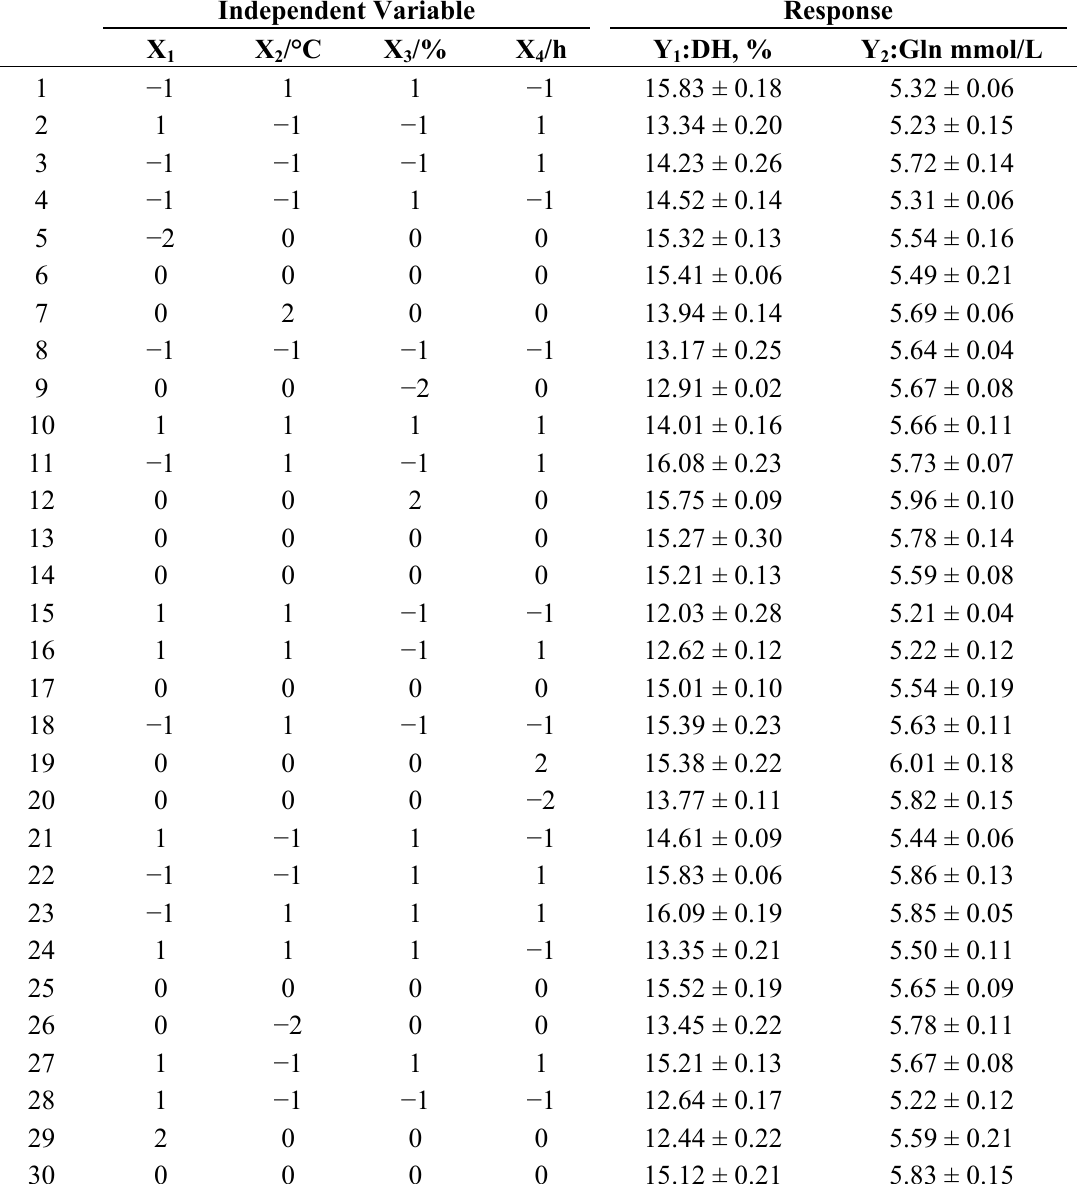
), pH (X ), E/S (X ) and reaction time (X 1 2 3